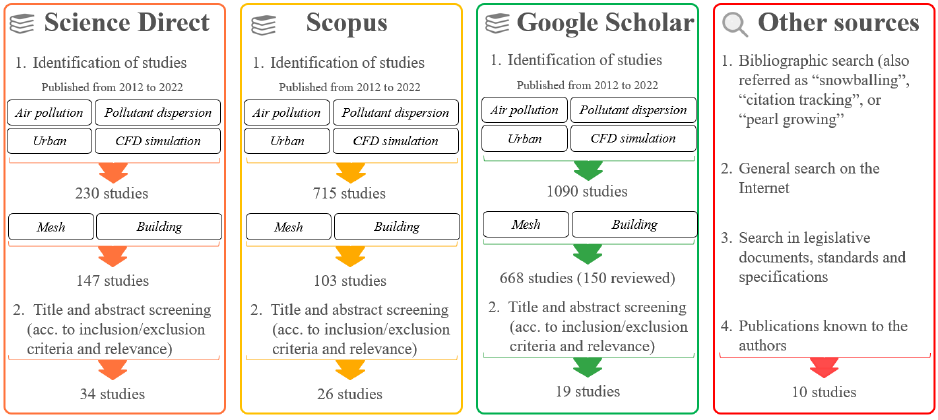
Figure 2. Literature search